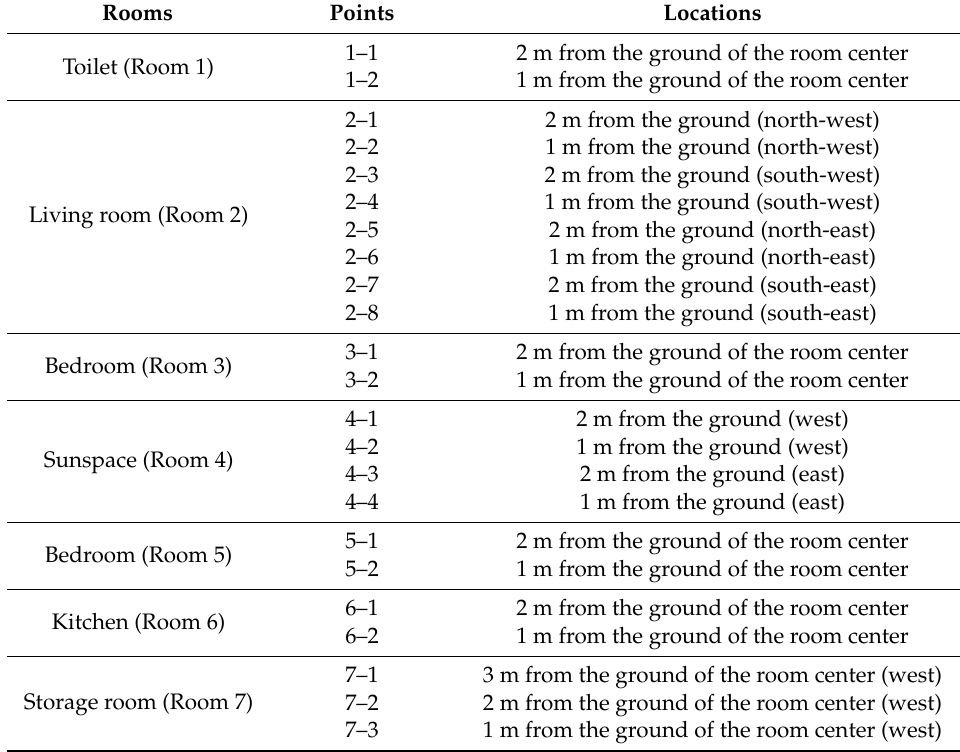
Table 2. Locations of indoor measuring points.